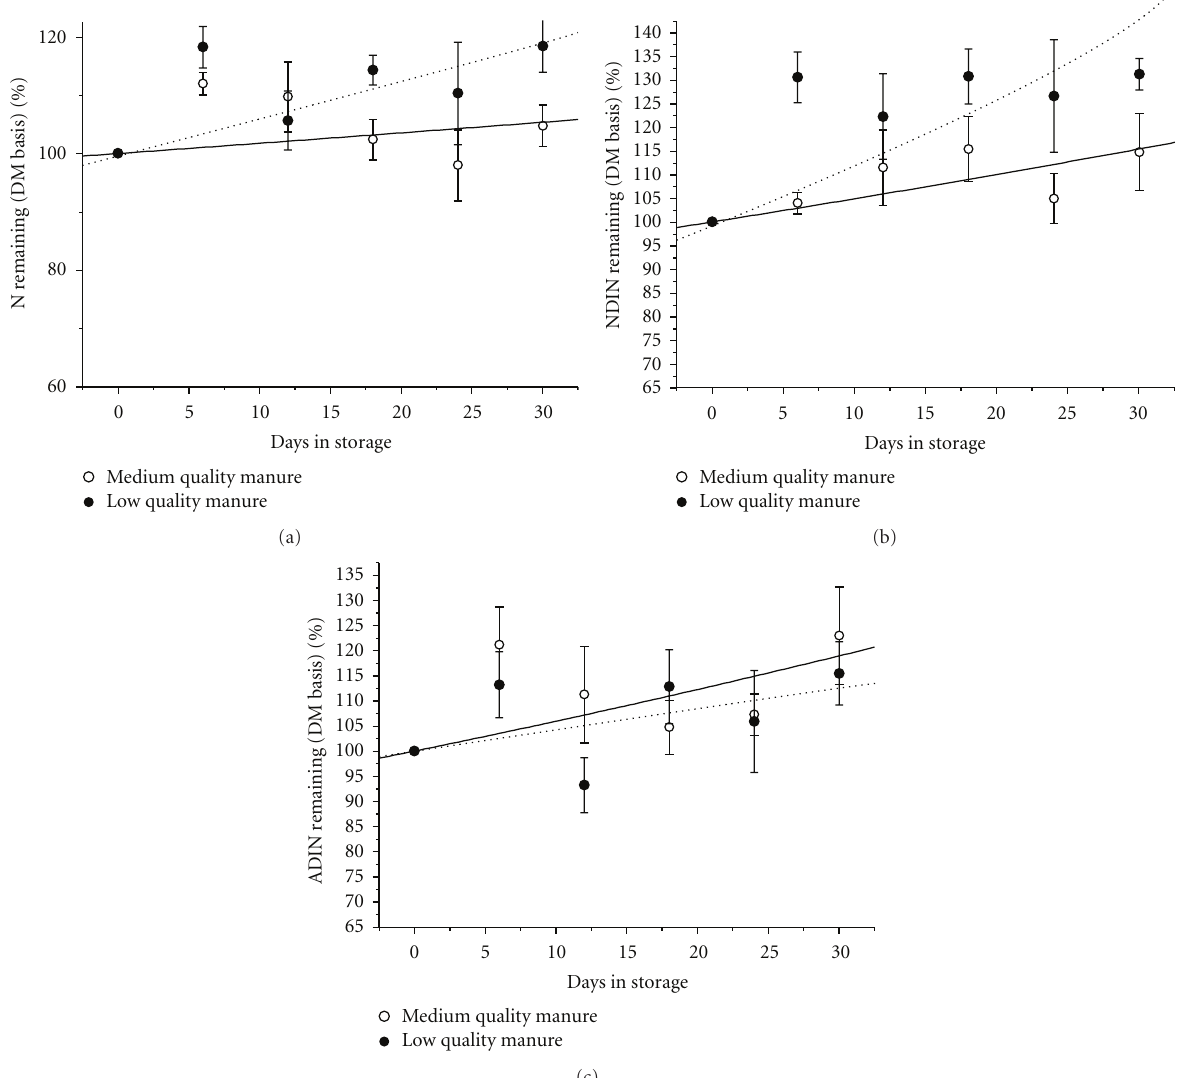
Figure 5: Total organic N, neutral detergent insoluble N (NDIN), and acid detergent insoluble N (ADIN) dynamics in manure in the rainy season experiment (DM basis). Error bars represent standard error of means. Continuous lines represent regression equations for organic N dynamics in manure during the rainy season experiment. Solid lines (—) represent the best fit regression lines for Medium quality manure treatments. Dashed lines (----) represent the best fit regression lines for Low quality manure treatments. Y represents the amount of organic N, NDIN, or ADIN remaining in the manure (% of initial content, DM basis). (a) Total organic N dynamics (%N, DM basis). Medium quality manure: Y = 100 e 0 . 00174 x , R 2 = 0 . 989. Low quality manure: Y = 100 e 0 . 00576 x , R 2 = 0 . 986. The rate equations for organic